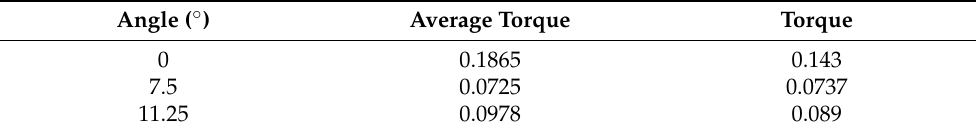
Figure 11. Cogging torque as a function of rotation angles for three relative angles between opposite teeth. ( a ) 0°; ( b ) 7.5°; ( c ) 11.25°. Table 3. Average and standard cogging torque for different angles between opposite teeth.